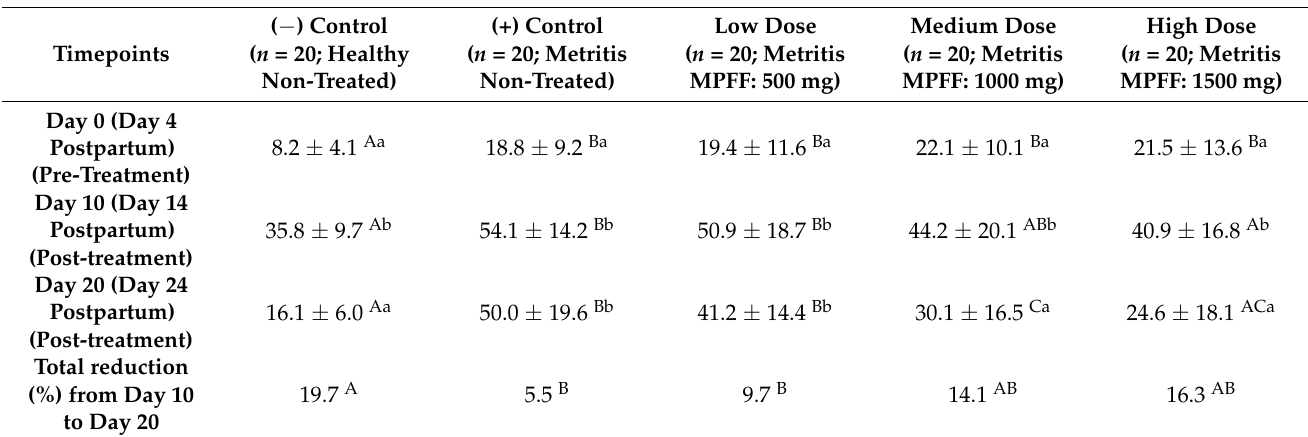
Table 8. Effects of intrauterine infusion of Micronised Purified Flavonoid Fraction (MPFF; low, medium and high concentrations) on the percentage (% PMNs) from intrauterine swab samples (Cytobrush) on days 0, 10 and 20 (days 4, 14 and 24 postpartum, respectively) in metritis-diagnosed dairy cows naturally infected by E. coli during the early postpartum period.